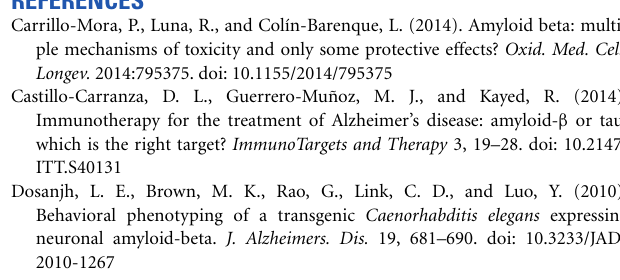
(B) Time course of the percentage of eggs that hatched from day 0 (the day of egg lay) to day 3 for both strains. Error bars indicate standard error of the